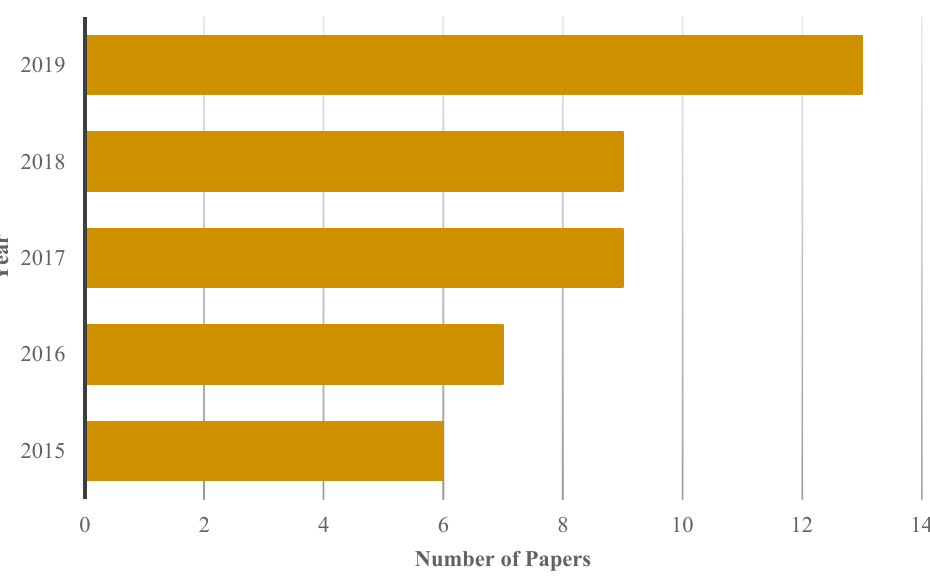
Figure 1. Comparing the number of applicable studies done in each year.